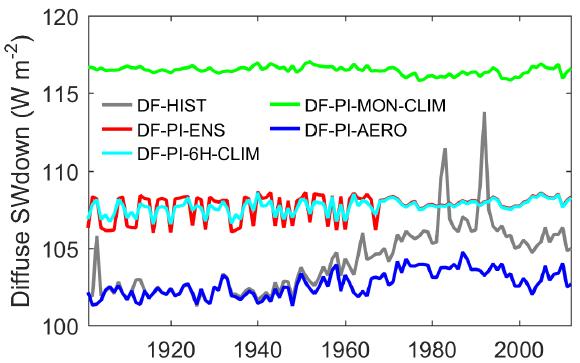
Figure 6. Mean diffuse incoming shortwave radiation at the surface from each